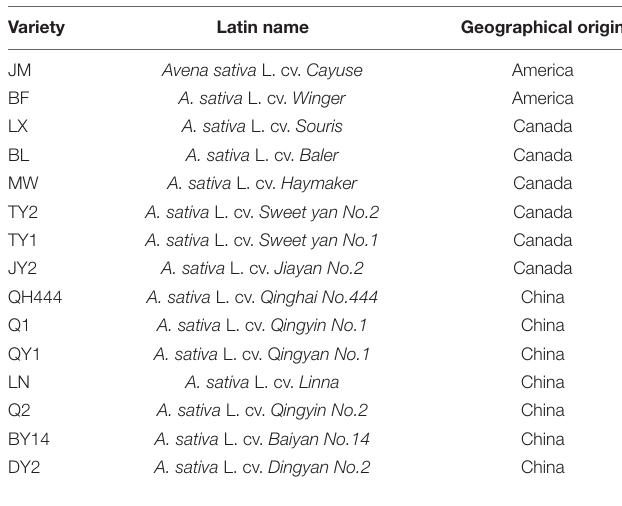
TABLE 1 | Names and sources of tested